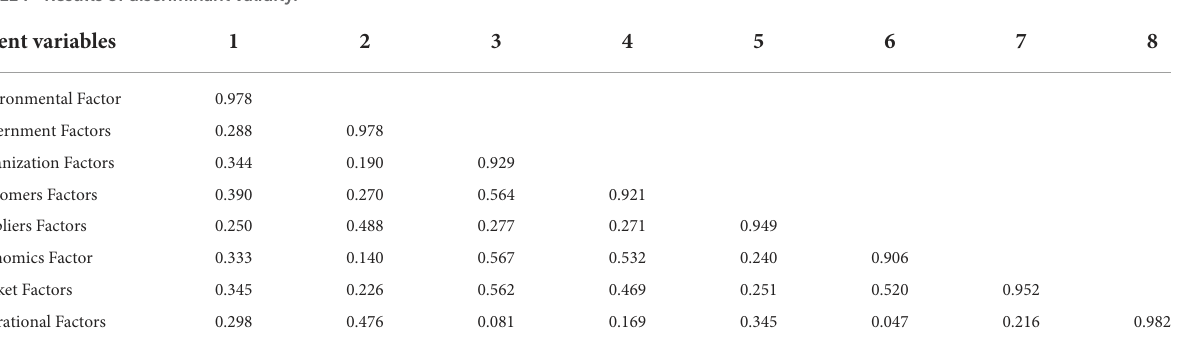
TABLE 7 Results of discriminant validity.